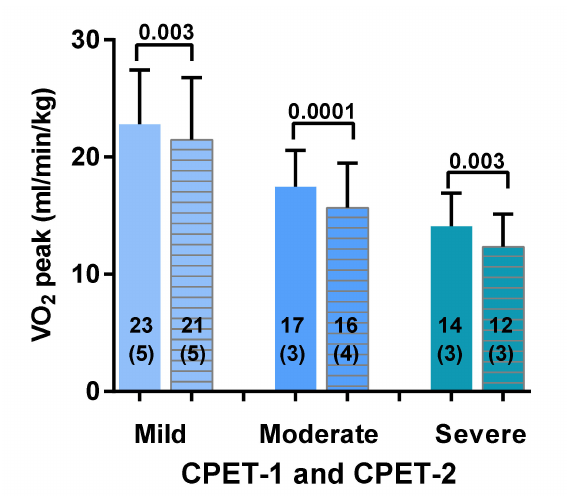
Figure 1. Peak oxygen consumption for both CPET-1 and CPET-2 for mild, moderate and severe ME / CFS. CPET: cardiopulmonary exercise test; VO 2 : oxygen consumption. For between group comparisons see the result section. CPET-1 is presented by a solid bar and CPET-2 is represented by a lined bar.